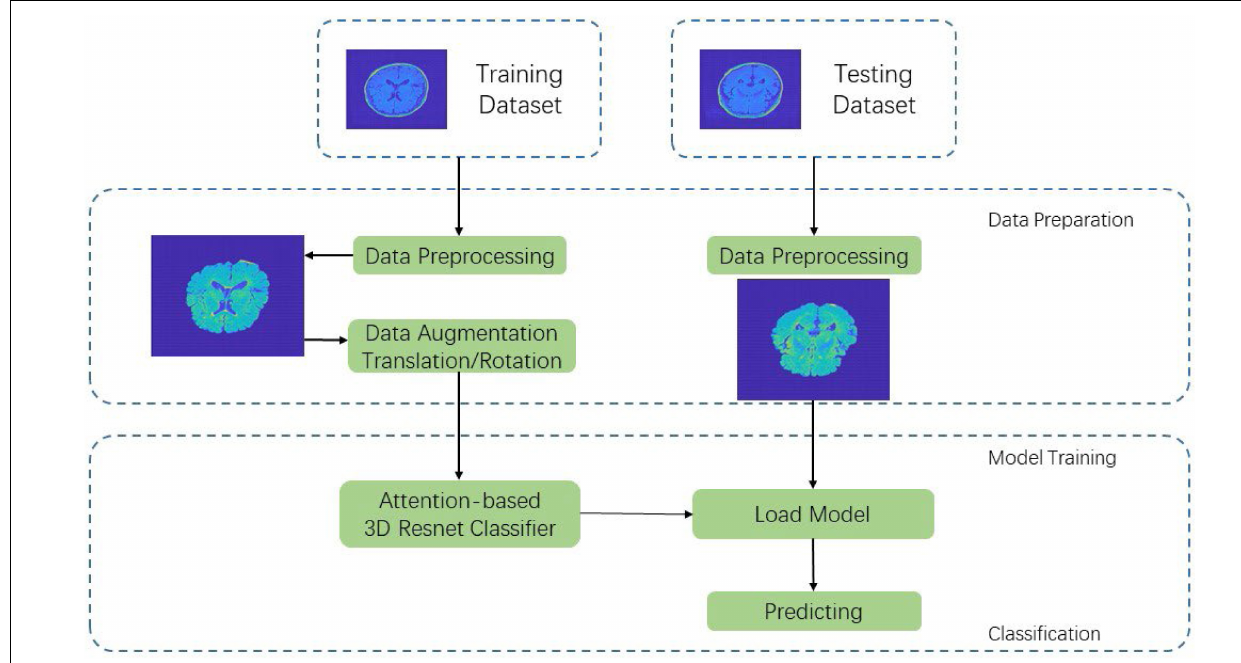
FIGURE 1 | MRI data processing pipeline.